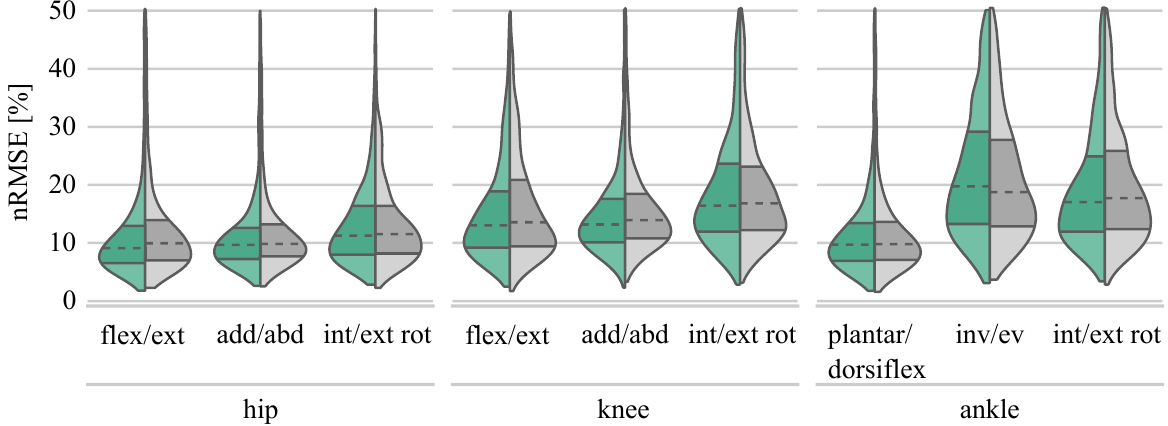
Figure 7. Distribution of the joint moment prediction RMSE values.